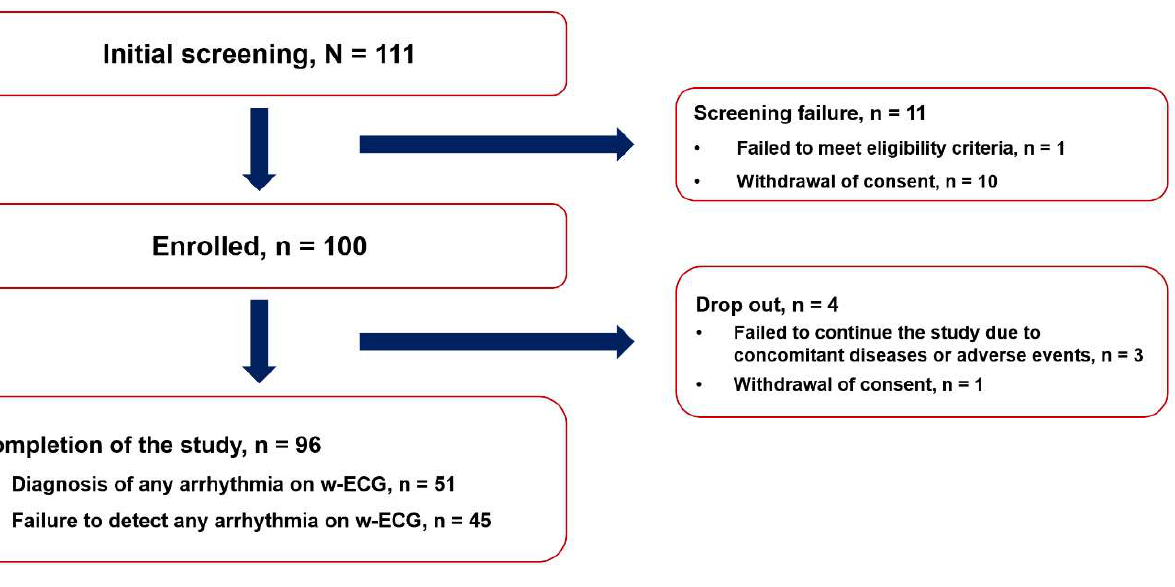
Figure 2. Study flow.